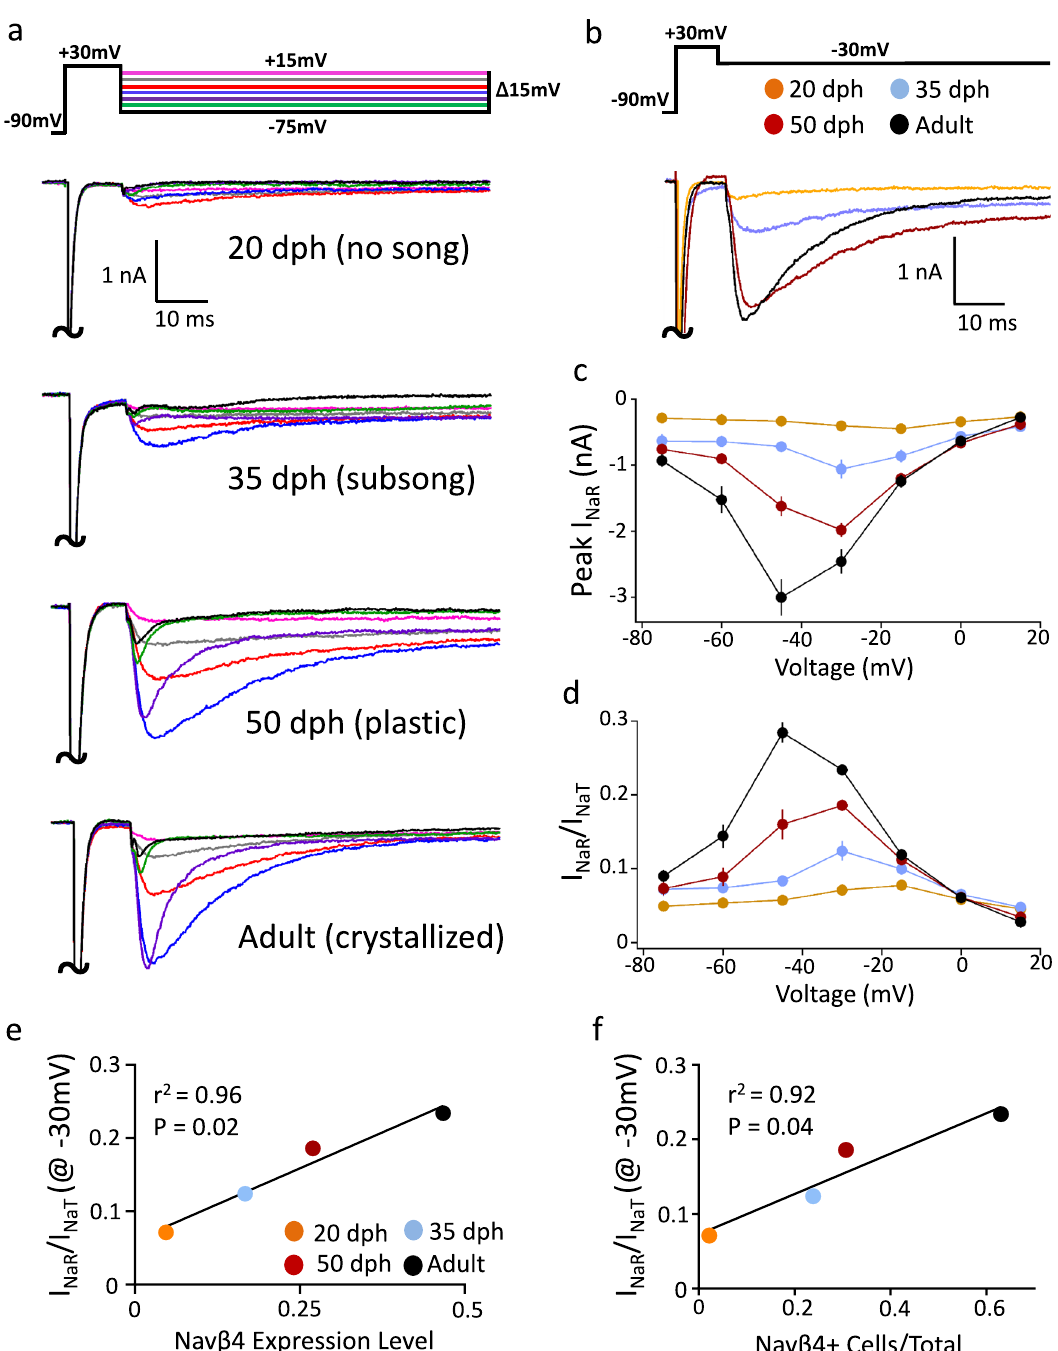
Fig. 4 Age-dependent changes in I NaR in RAPNs of male zebra fi nches. a Examples of transient ( I NaT ) and resurgent ( I NaR ) Na + currents elicited across ages (days post hatch, dph) by the voltage clamp protocol shown at the top. The large I NaT peaks have been truncated; the color code is the same as in Fig. 2c. b Representative currents from RAPNs at each age group during the − 30 mV test potential shown at the top. The large I NaT peaks have been truncated. c Average I – V curves for the peak I NaR in RAPNs from each age group (two-way ANOVA with Tukey ’ s post hoc comparisons; P = 3.7 × 10 − 35 , F (18, 280) = 16.98, N (cells/age) = 10/20 dph, 12/35 dph, 10/50 dph and 12/adults). Data are presented as mean values± SEM. d Average I – V curves after normalization of the peak I NaR to the peak I NaT measured in a given sweep then averaged across cells (two-way ANOVA with Tukey ’ s post hoc comparisons; P = 4.2 × 10 − 46 , F (18, 280) = 23.72, N (cells/age) = 10/20 dph, 12/35 dph, 10/50 dph, and 12/adults). Data are presented as mean values ± SEM. e Linear regression between the normalized average peak I NaR values at the − 30 mV test potential across ages and the average Nav β 4 expression level in RA (two-tailed; no adjustment for multiple comparisons). f Linear regression between the normalized average peak I NaR values at the − 30 mV test potential across ages and the proportion of Nav β 4-expressing cells in RA (two-tailed; no adjustment for multiple comparisons). For views of recorded slices across ages, see Supplementary Fig. 5a –